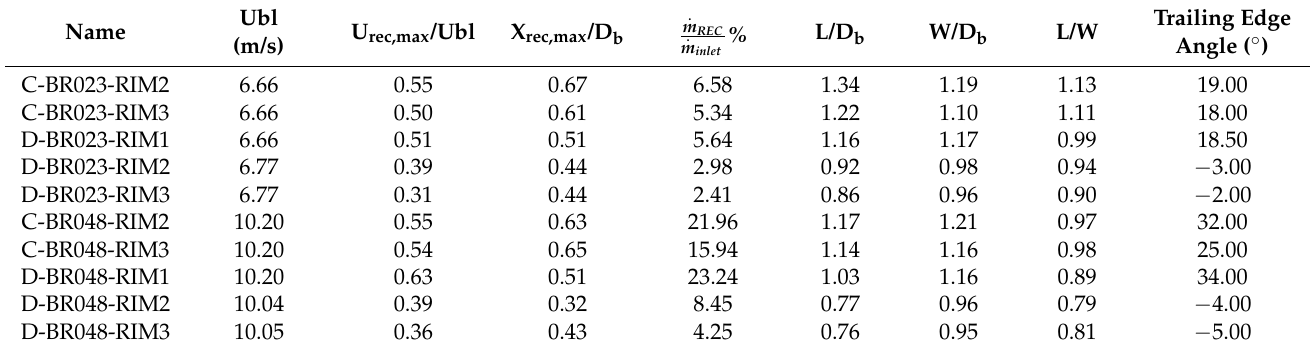
Table 1. Operational characteristics of the investigated cases and important global features of recirculation